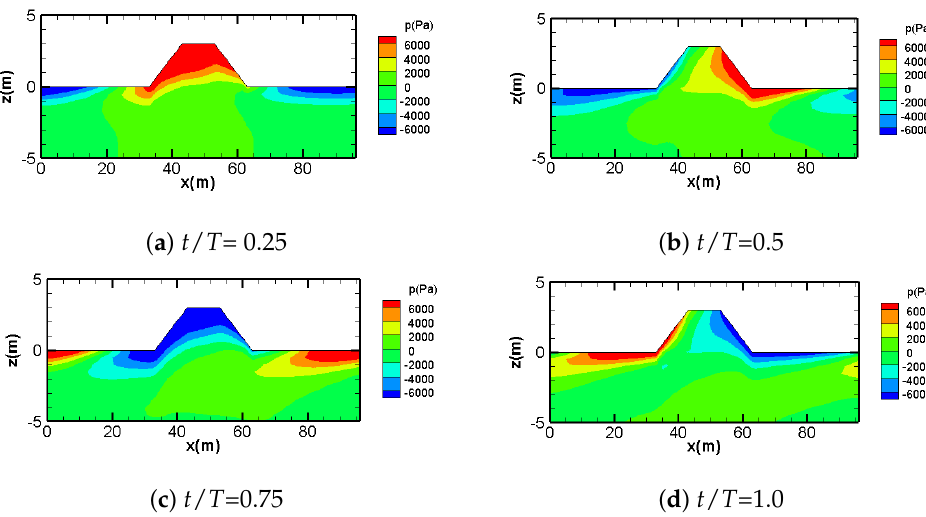
Figure 5. Distribution of the wave-induced pore pressure in the vicinity of the breakwater.